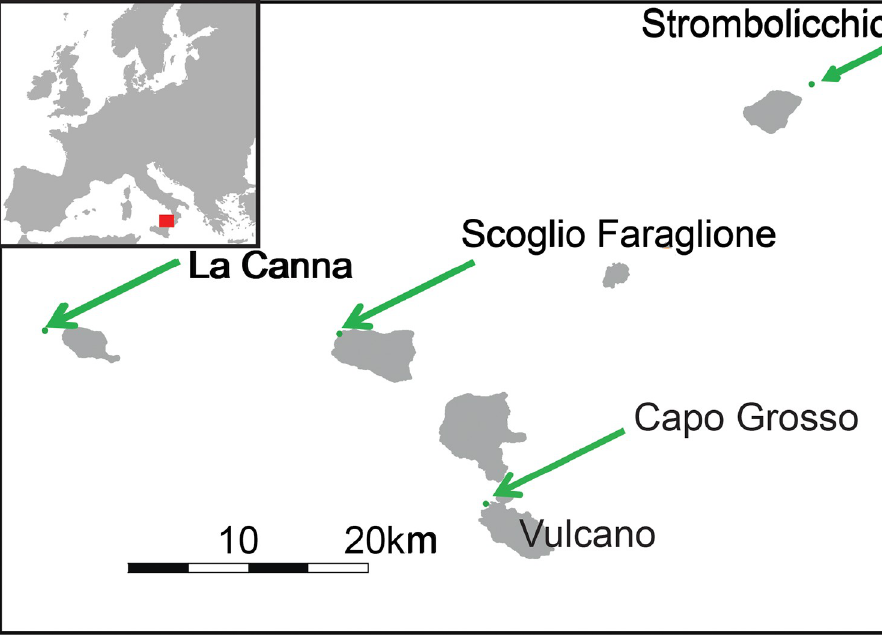
Fig 1. Distribution of the Aeolian wall lizard Podarcis raffonei . Distribution of the extant populations of Podarcis raffonei . The figure has been drawn by GFF on the basis of public domain shapefiles at http://www.naturalearthdata. com/.